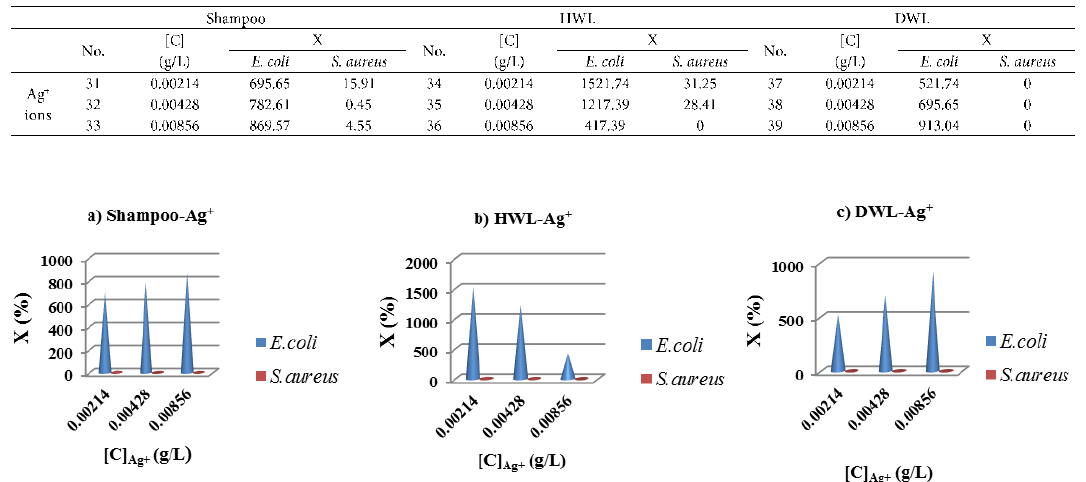
Table 2. Percentage growth (X) of E. coli and S. aureus after 1 h vicinage time in prepared detergent samples with Ag + ions released from Ag NPs in distilled water during 6 months.